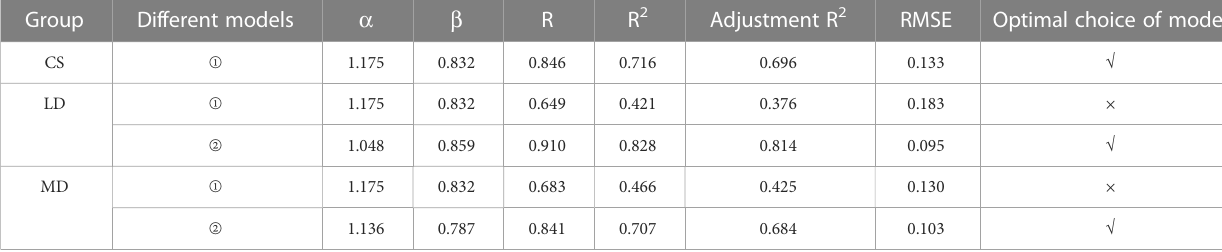
TABLE 3 Fitting parameters and inspection indexes under different drought conditions.